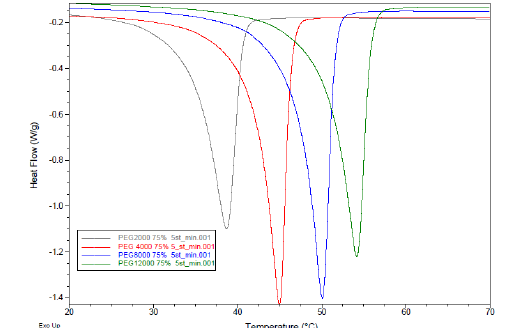
Figure 3. DSC results- curves for materials with different type of polyethylene glycols: 2000(grey), 4000 (red), 8000 (blue), 12000(green).